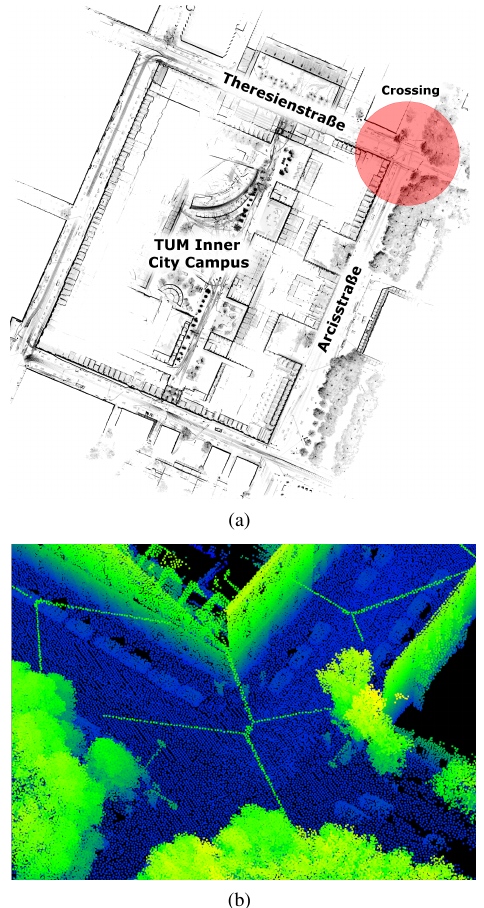
Figure 4. The scene used for evaluation. (a) Overview. (b) Accumulated Point cloud of the crossing.